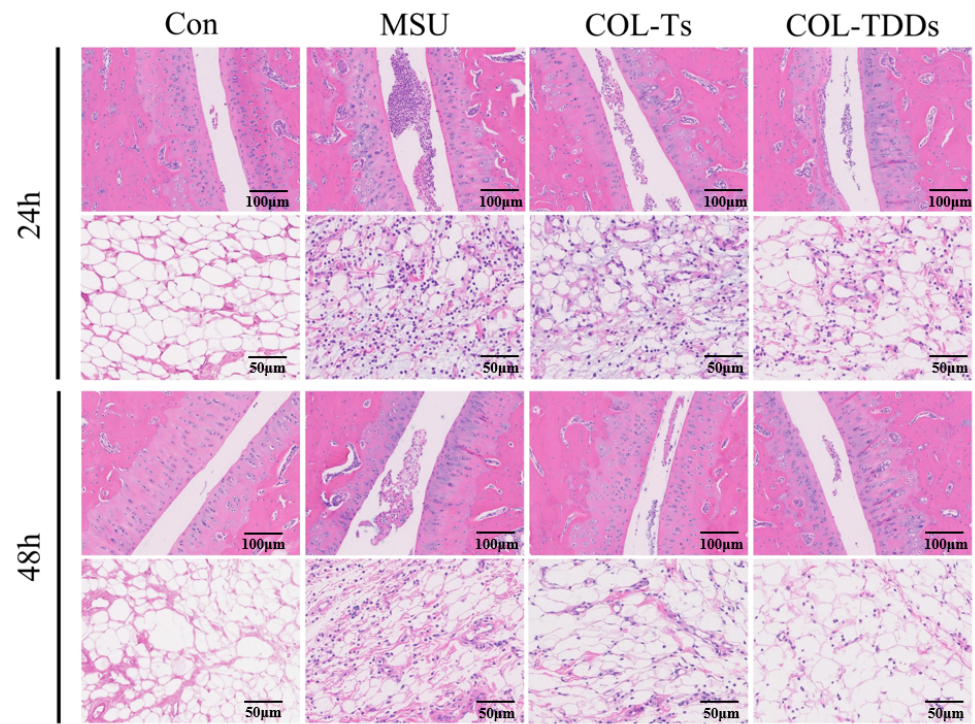
Figure 7. Histopathological study of ankle joints obtained 24 h and 48 h post-MSU injection.